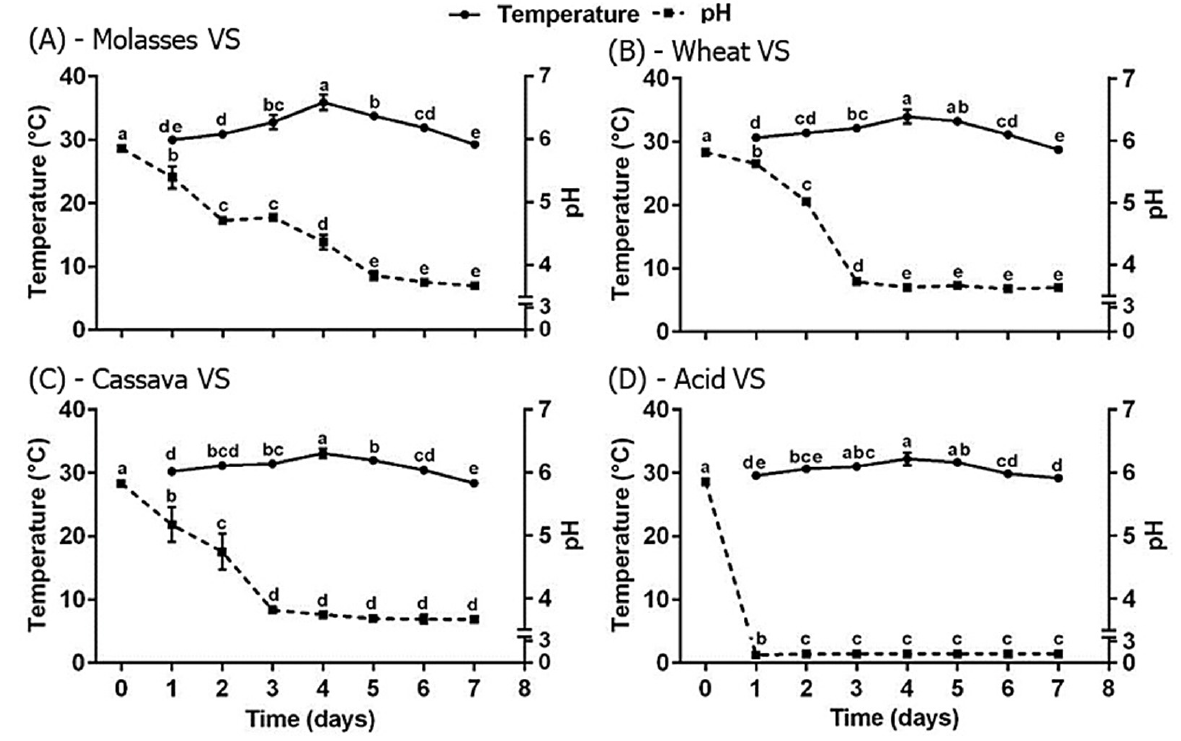
Figure 2. Temperature and pH of viscera silage stored for 7 days: ( A ) molasses VS; ( B ) wheat VS; ( C ) cassava VS; ( D ) acid VS.